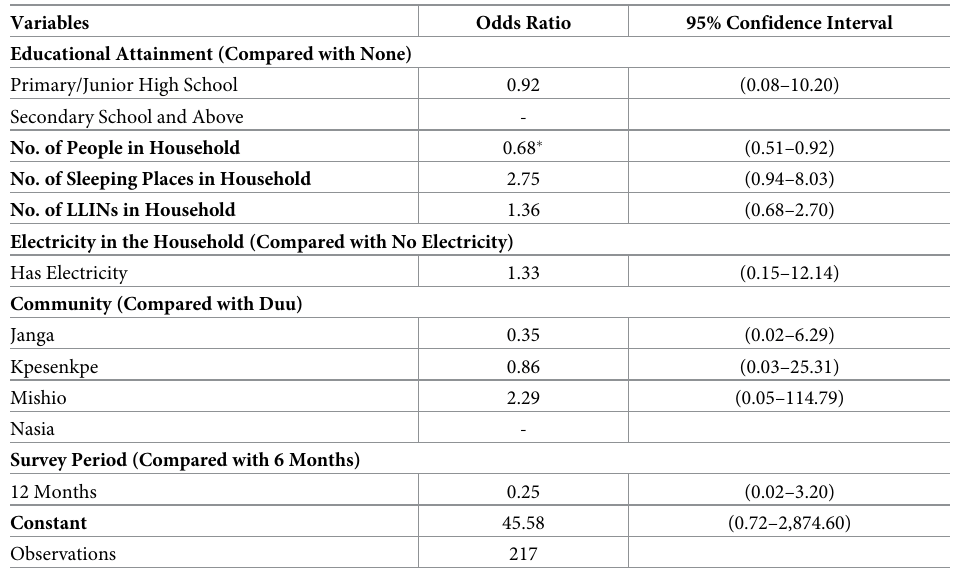
Table 5. Logistic regression of factors associated with pHI of